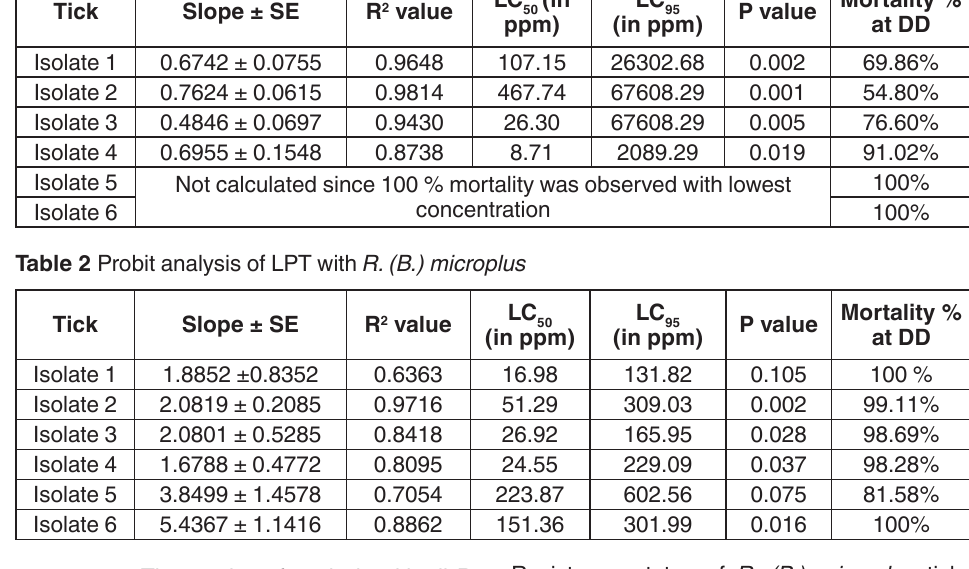
Mortality % lc (in lc 50 95 P value at DD ppm) (in ppm)